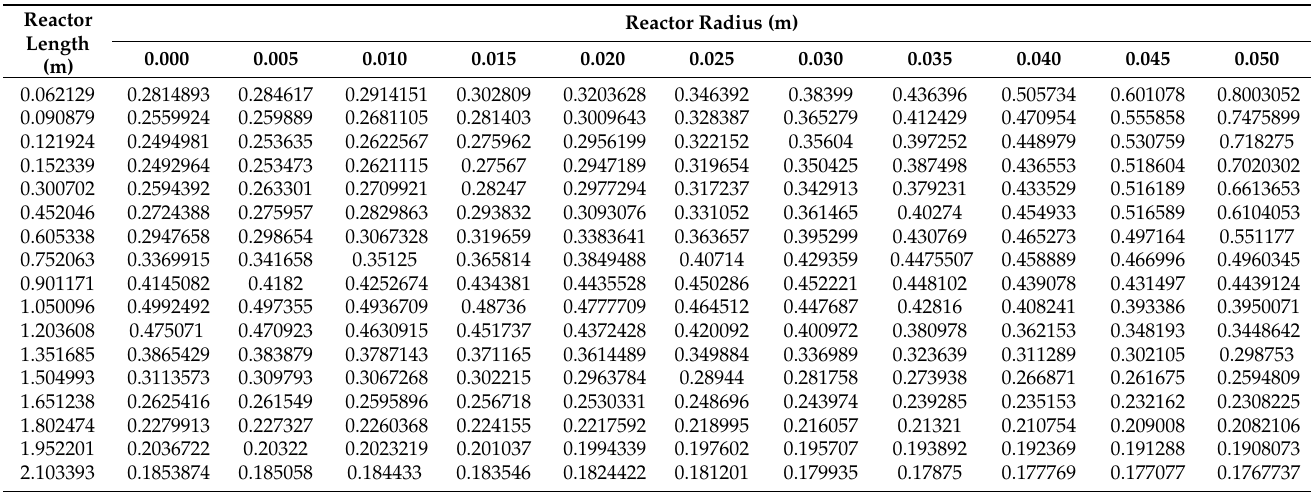
Table A3. Results of the simulation of the Thiele modulus of each particle located at specific points of the radius and length of the reactor. Made with the program particula.pol .